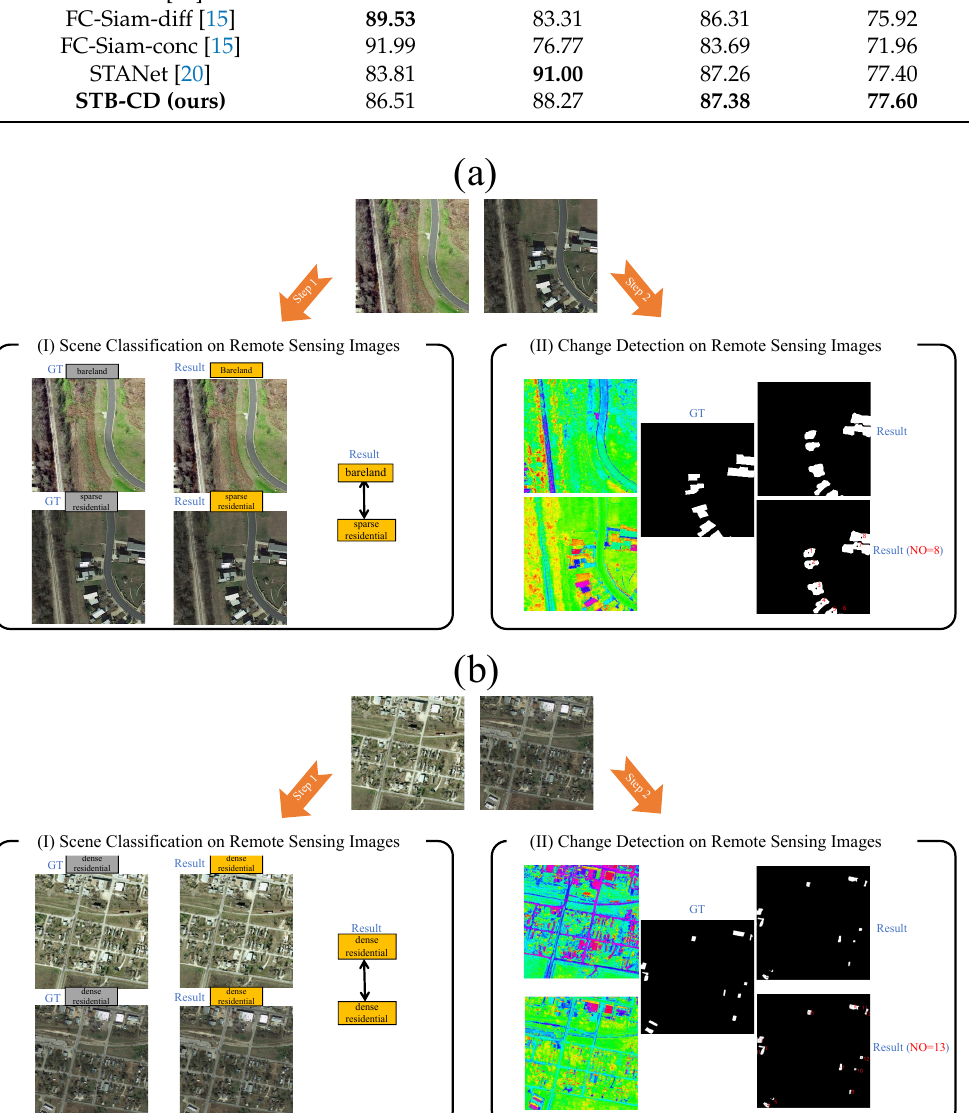
Figure 6. Visualization results of scene changes understanding ( a , b